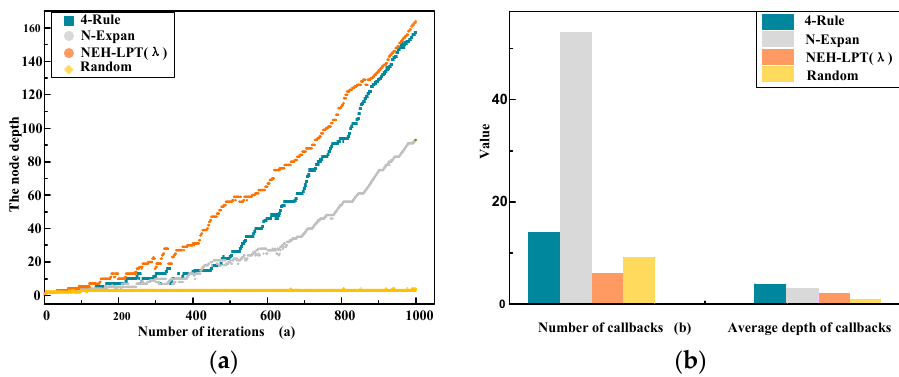
Figure 2. Schematic of the HFSSP state evolution: ( a ) the relationship between the number of iterations and the node depth; ( b ) the number of callbacks and average depth of callbacks for each simulation policy.